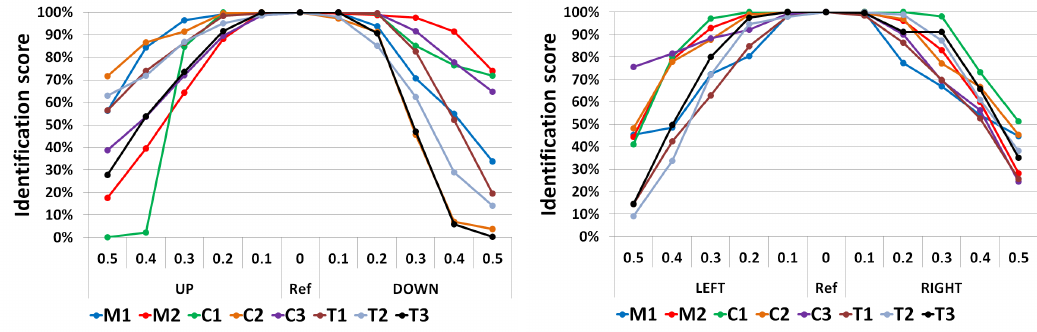
Figure 10. The identification scores obtained using the cfCNN architecture when translating the bounding box. M(i), C(i), and T(i) refer to each target used in the dataset.